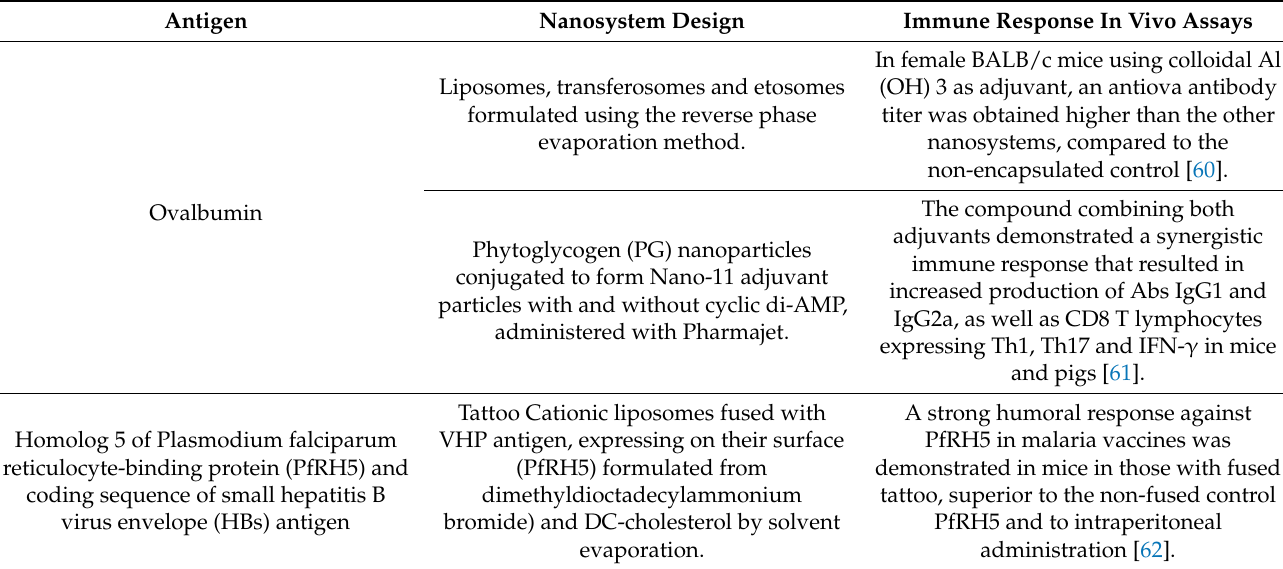
Table 1. Transdermal nanovaccine designs for various antigens using novel nanosystems and their immune response from in vivo